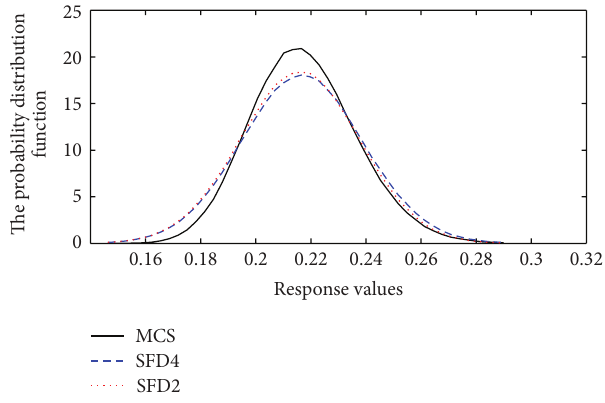
Figure 2: The pdf at point 𝐵 using SFDHC and MCS.